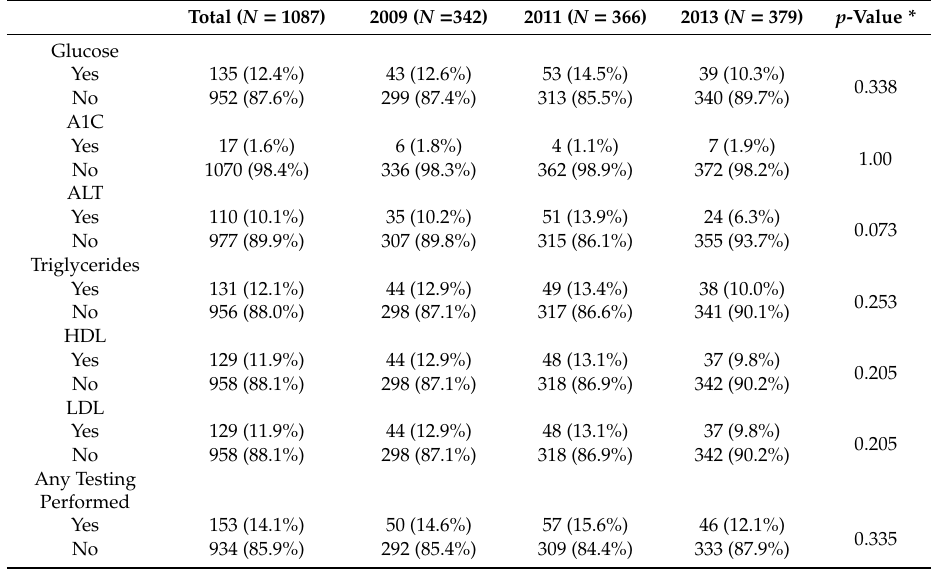
Table 3. Proportion of patients with laboratory tests